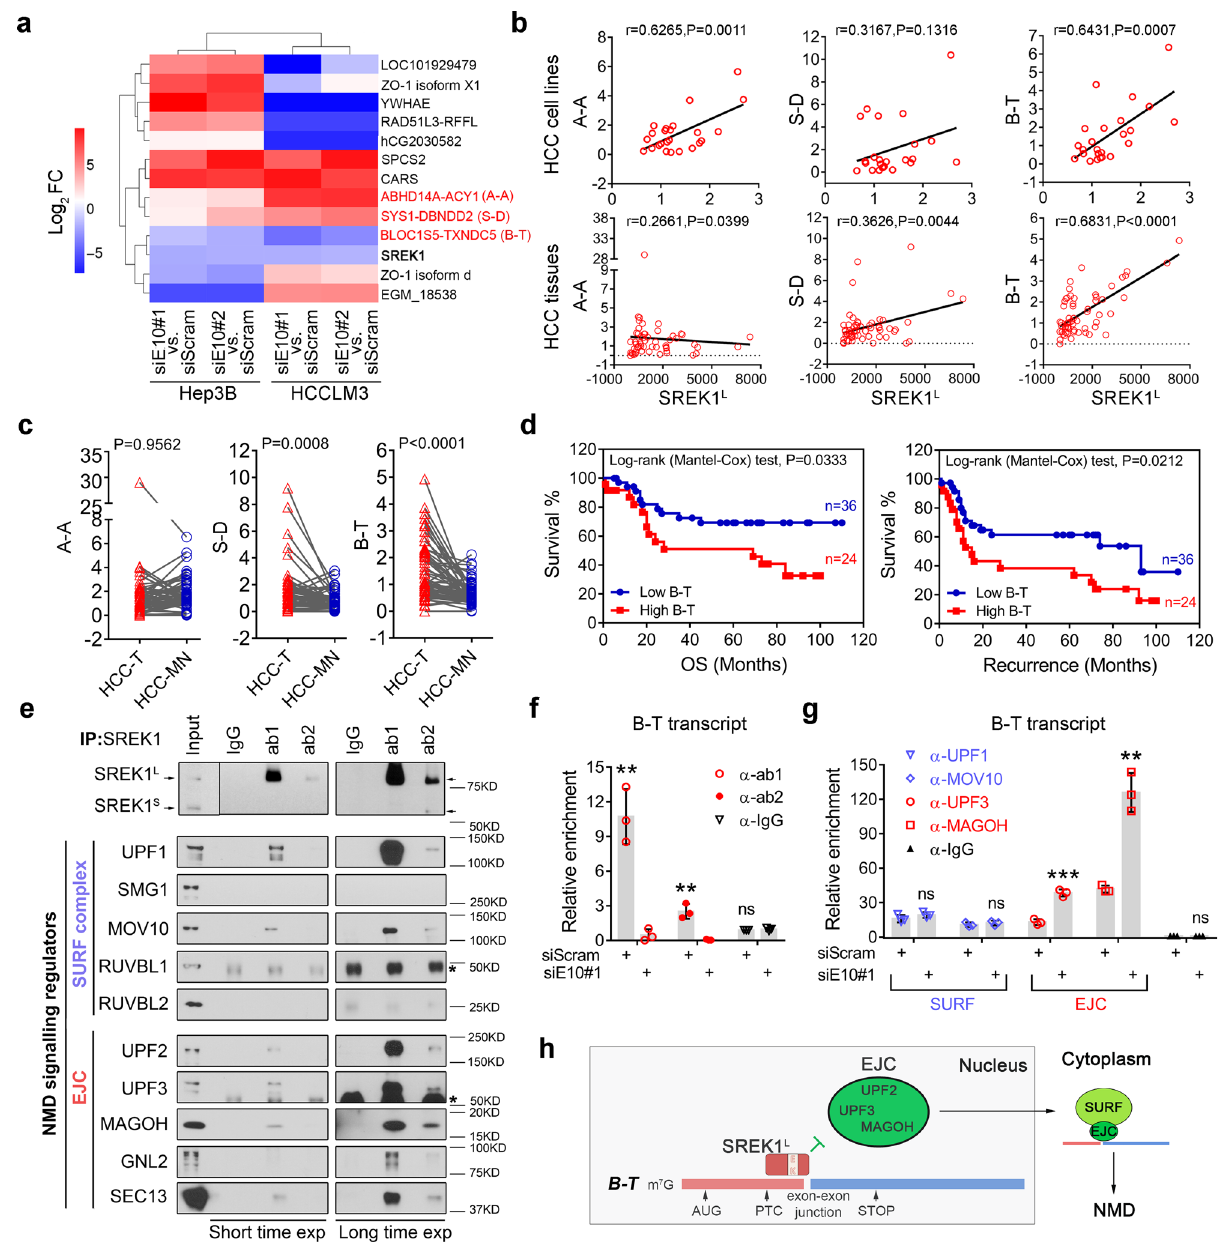
Fig. 3 SREK1 L maintains the expression of B-T, an NMD target, via inhibiting the exon-exon junction complex binding to the B-T transcript. a Expression heat map of scramble (siScram)-transfected or SREK1 L -knockdown (siE10#1 or #2) HCC cell lines mediated by siRNA. Targeted NMD genes are labeled in red. b Pearson correlation assay to assess the expression of three NMD target genes and SREK1 L in 24 HCC cell lines or 60 HCC tumor tissues. c The expression of three NMD target genes in 60 tumor (T) and matched normal (MN) tissues, two-tailed, paired t test is used. d Analysis of OS and disease-free survival in 60 HCC patients with either high or low B-T expression. e Endogenous immunoprecipitation of SREK1-associated components from the SURF or EJC complex in Hep3B cells using IgG or two commercial antibodies against SREK1 (ab1: recognizing SREK1 L , ab2: recognizing both L and S forms of SREK1). The star symbols indicate the heavy chain. The RNA immunoprecipitation assay for the detection of the enrichment of f SREK1, or the components of NMD complexes g UPF1, MOV10, UPF3, MAGOH on the B-T transcript in scram control or SREK1 L knockdown Hep3B cells ( n = 3, biologically independent experiments), data are shown as the mean ± SD, ** p < 0.01, *** p < 0.001. h A proposed potential regulatory model of SREK1 L protecting B-T from NMD via inhibiting the EJC binding to B-T transcript in HCC cells. Two-tailed, unpaired t test is used for ( b , f , g ). Source data are provided as a Source Data fi